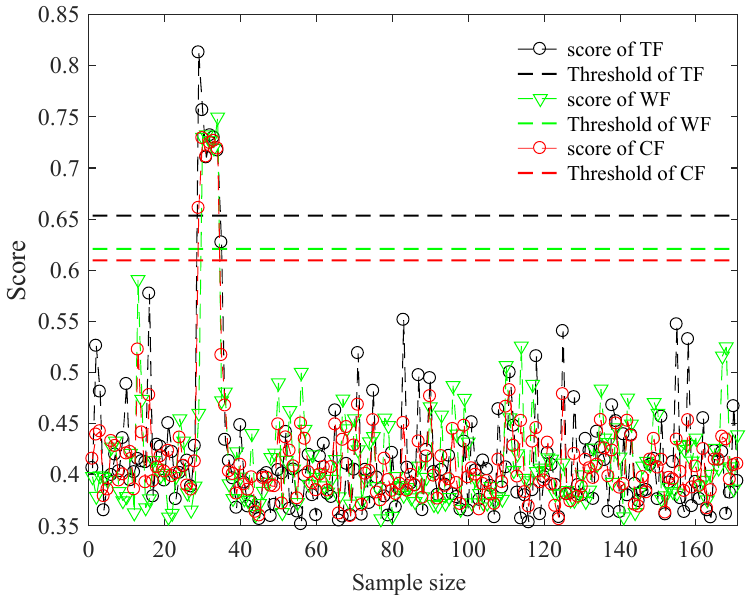
Figure 4. Anomaly score based on TF, WF and CF.